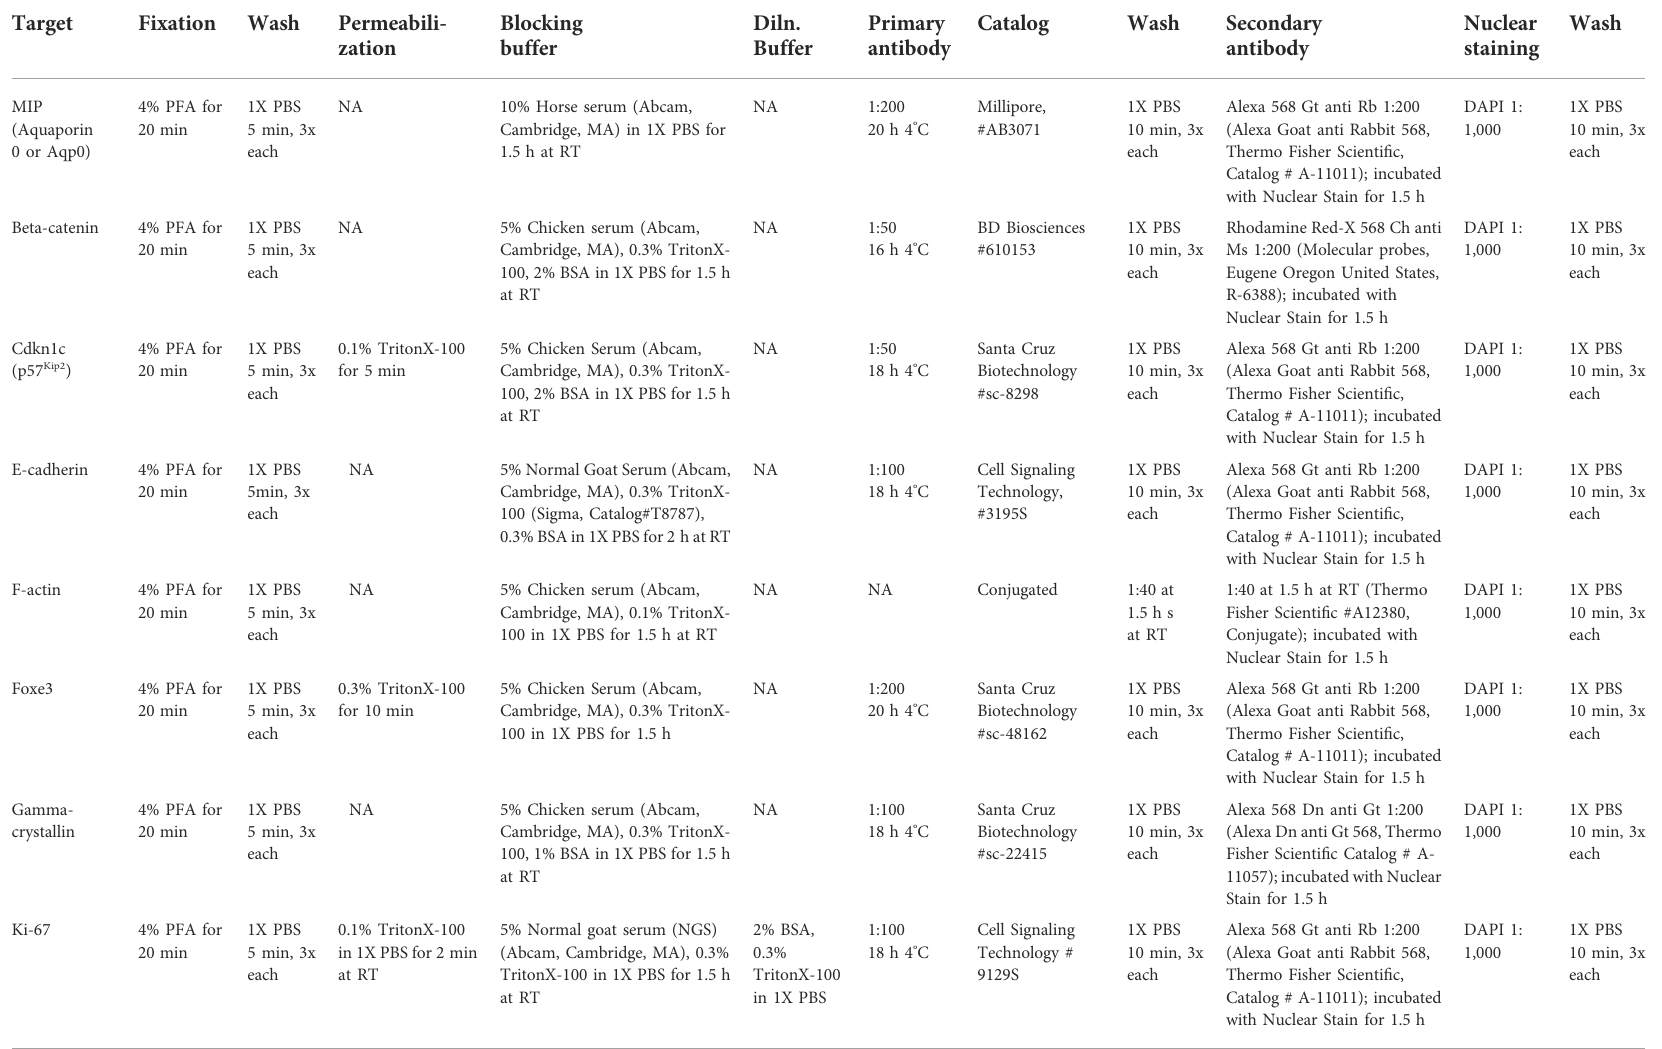
TABLE 1 Antibodies and immunostaining